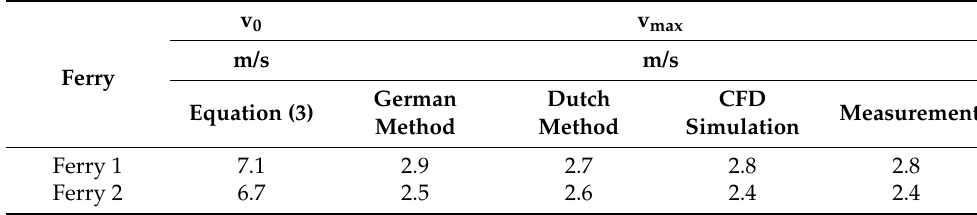
Figure 14. Efflux velocities for the thrust 105 kN, 130 kN and 160 kN, respectively. Table 4. Maximum velocities generated by the bow thrusters on the seabed calculated for the axial velocity obtained from Equation (2) compared to the results of simulation and